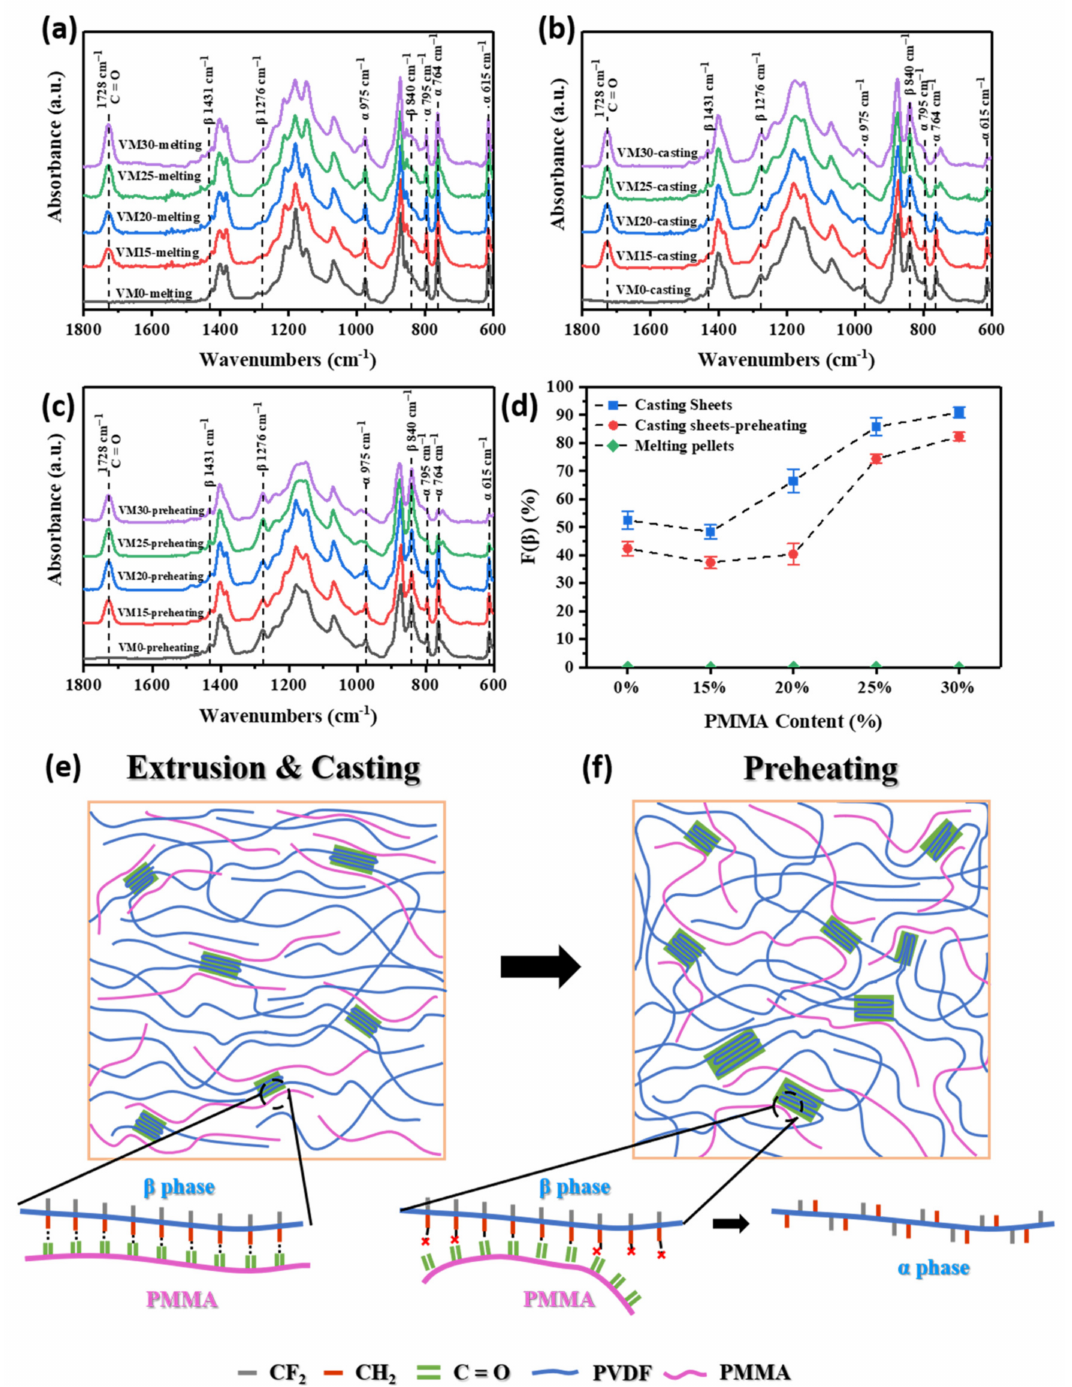
Figure 3. FTIR spectra of ( a ) the thermal-history free VM; ( b ) VM casting sheets; ( c ) VM casting Scheme 140 ◦ C; and their ( d ) β phase fractions. ( e , f ) Schemes of chain orientations and evolution of α - β phases in casting sheets during extrusion, casting and preheating